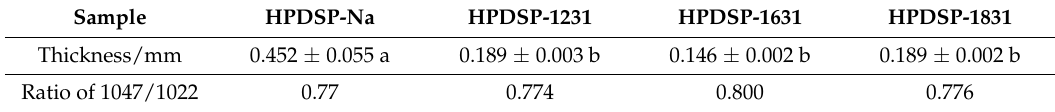
Figure 3. Continuous and stable blowing of HPDSP-OMMT film.